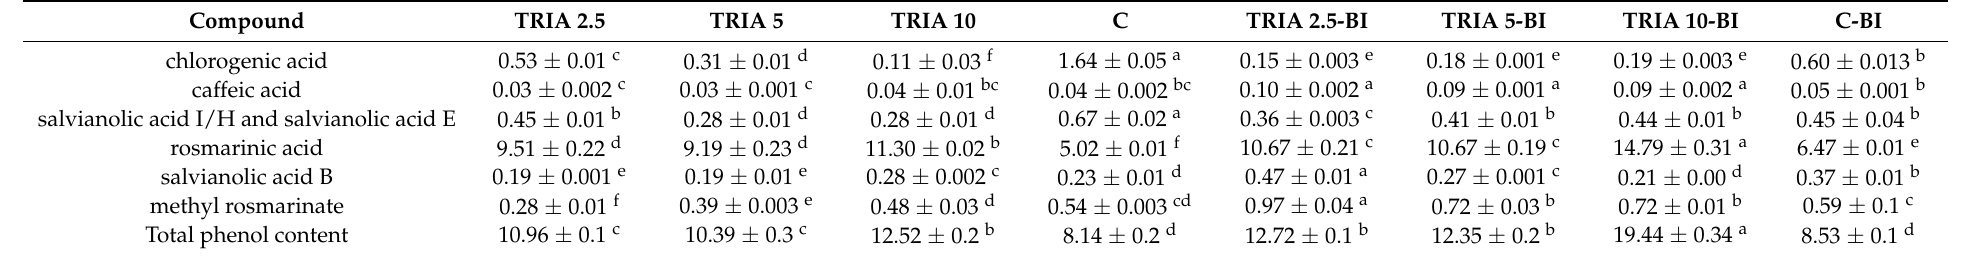
Table 2. The effect of TRIA on the accumulation of phenolic compounds in D. forrestii shoot cultured five weeks on MS medium containing triacontanol (TRIA) ( µ g/L) or triacontanol and 0.5 mg/L BAP and 0.2 mg/L IAA (TRIA-BI), C-medium without growth